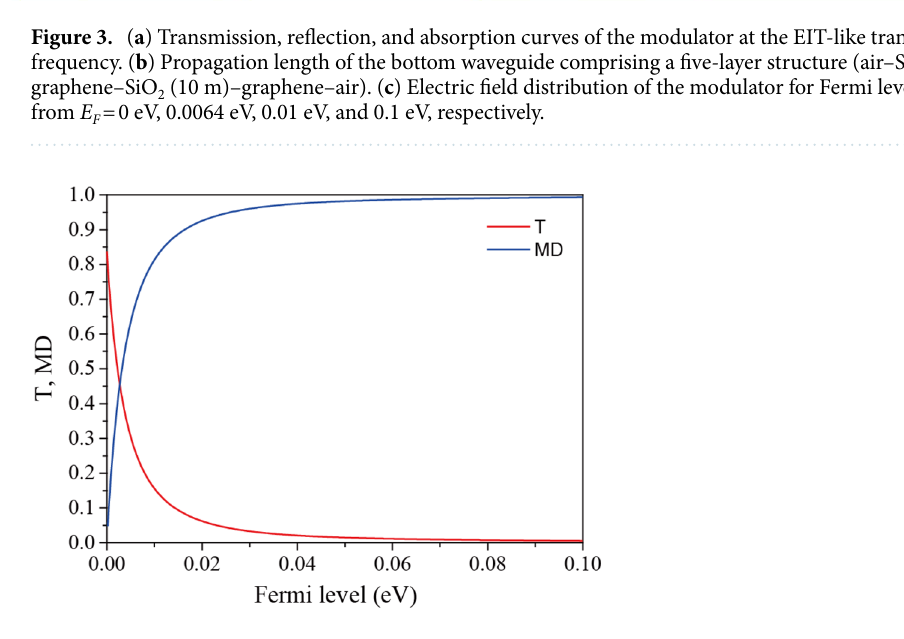
Figure 4. Transmission and modulation depth as a function of the Fermi level at the EIT-like transmission